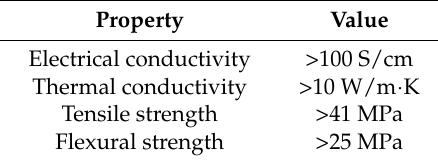
Table 1. Overall requirements for bipolar plates in fuel cells